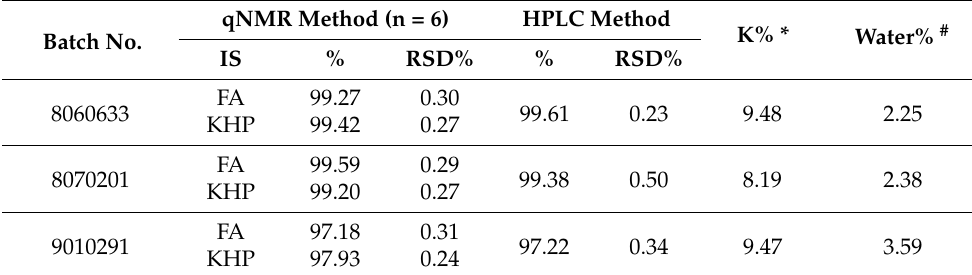
Table 5. Determination results of the purity